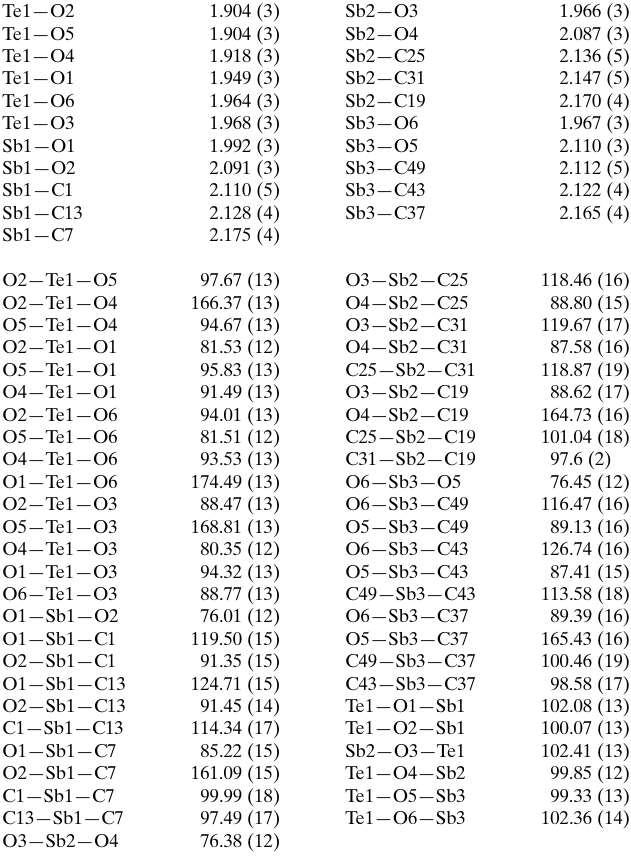
Table 1 Selected geometric parameters (A˚ , (cid:4)